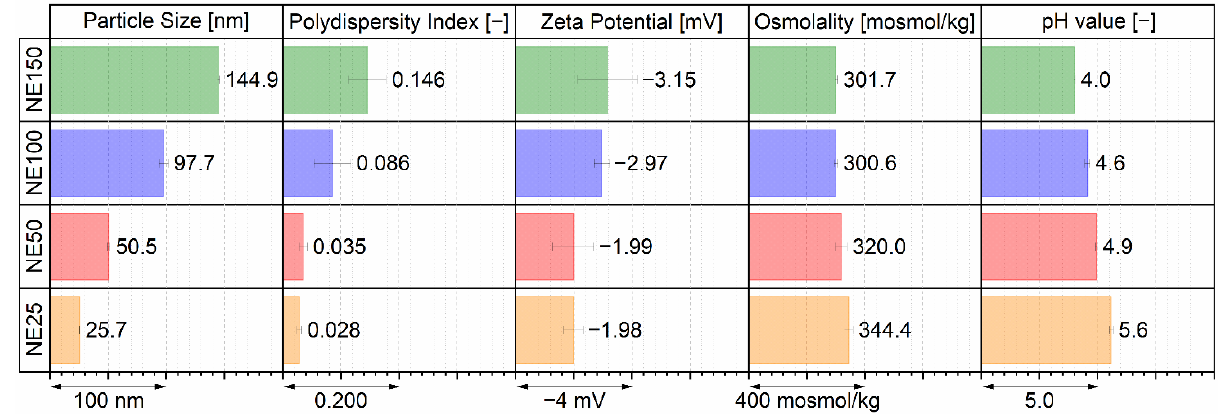
Figure 2. Physicochemical properties of the four different sized nanoemulsions, determined by three individual produced batches.